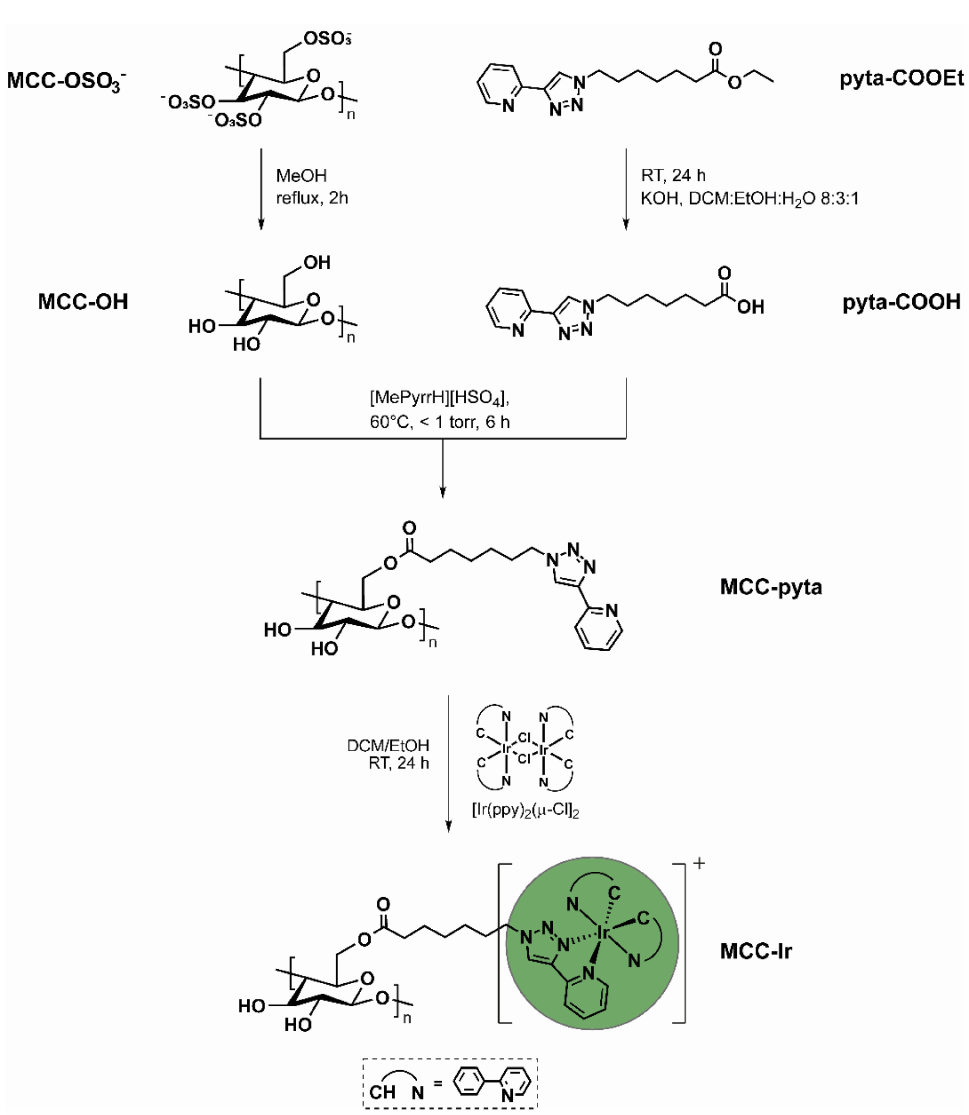
Figure 1. Synthetic approach for the conjugation of luminescent iridium (III) complex to the MCC surface starting from sulfated MCC and the previously reported pyridyl triazole ligand